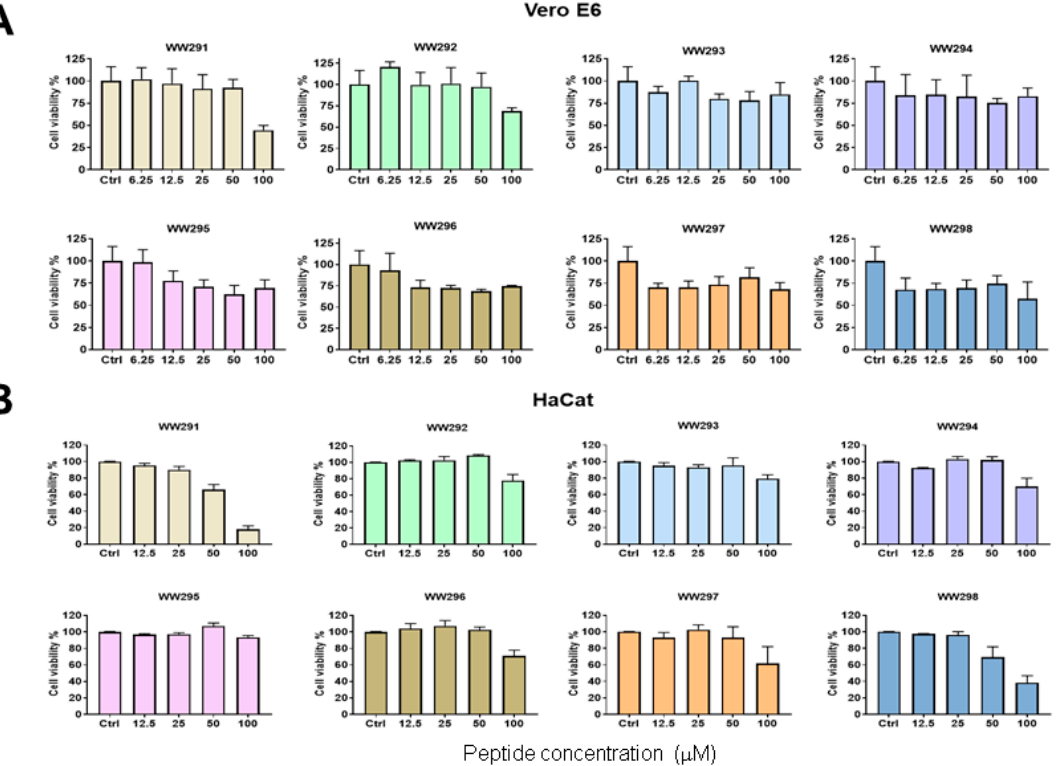
Figure 1. Assessment of the cytotoxicity of sequence permutated WW peptides on monkey kidney Vero E6 cells ( A ) and human epidermal keratinocyte cell line (HaCaT) ( B ). Peptides were tested at different concentrations (6.25 to 100 µM in panel A and 12.5-100 µM in panel ( B )). Cell viability was quantitated using the standard MTS assay as described in Methods.